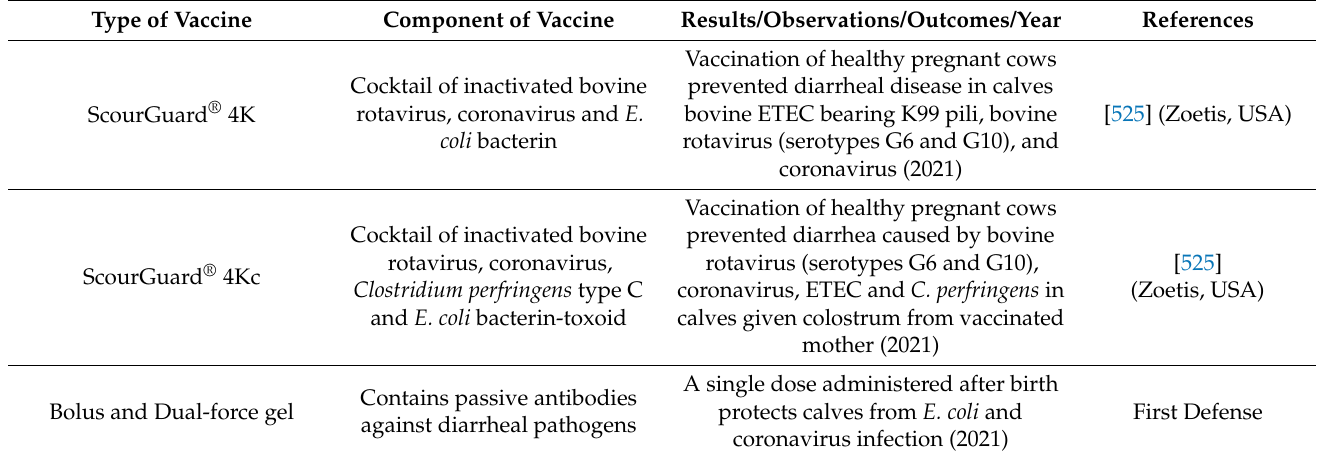
Table 7. Reports concerning bovine colibacillosis treatment/vaccine